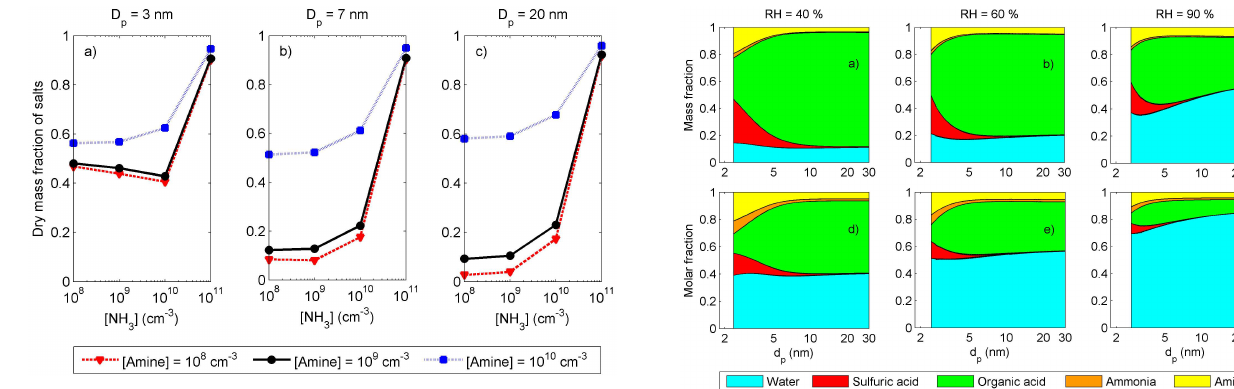
Fig. 7. Mass (a, b, c) and molar (d, e, f) fractions as a function particle size in simulations where RH was 40% (a, d) , 60% (b, e) and 90% (c, f) . Concentrations of sulfuric acid (10 6 cm − 3 ) , ammo- nia (10 9 cm − 3 ) and amine (10 9 cm − 3 ) , RH (40%) and temperature (283.15K) were set to base case values. Concentration of organic acid was 3 × 10 8 cm − 3 and p sat , Org . acid was 10 − 6